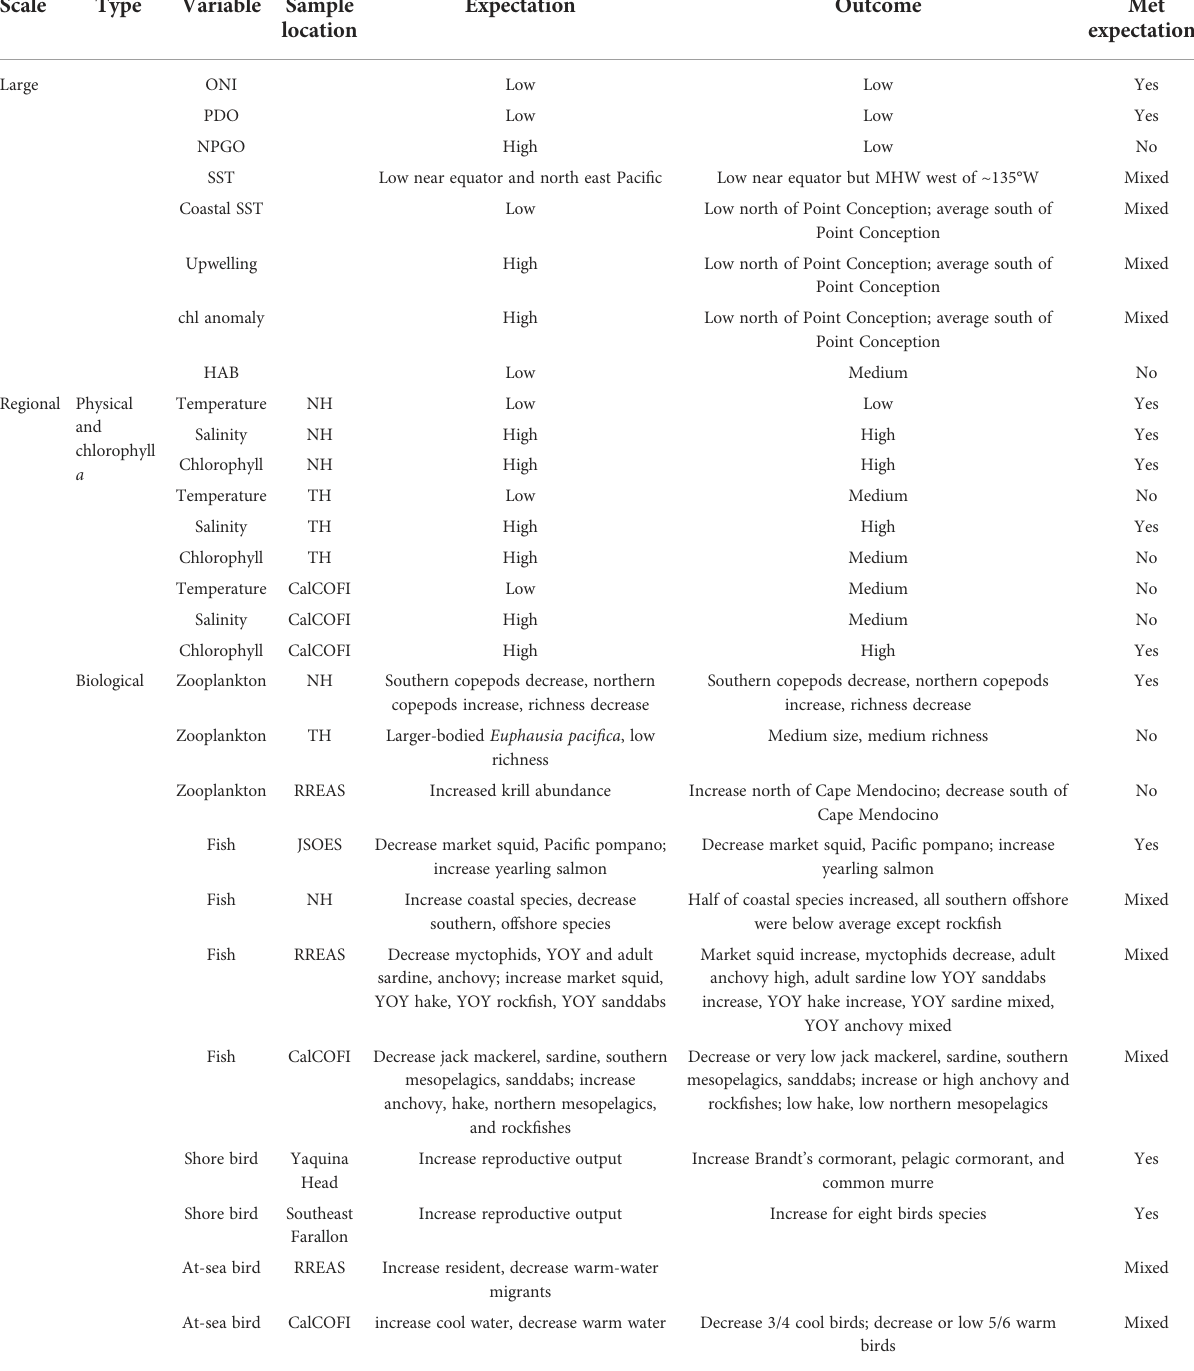
TABLE 1 Physical and biological data